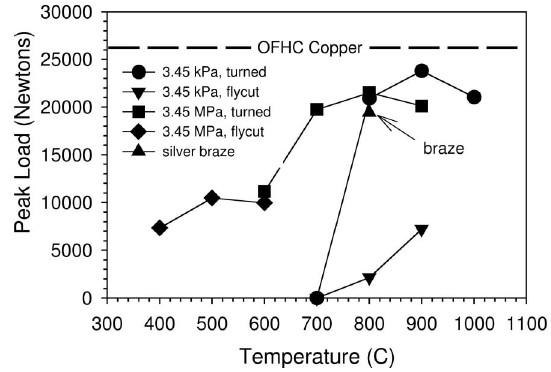
FIG. 12. Diffusion bond strength for two different bonding pressures [3.45 kPa (0.5 psi) and 3.45 MPa (500 psi)] and two different surface finishes (diamond turned and diamond fly cut) as a function of temperature. The strength of a silver braze (triangle) is shown at 800 ± C for comparison.